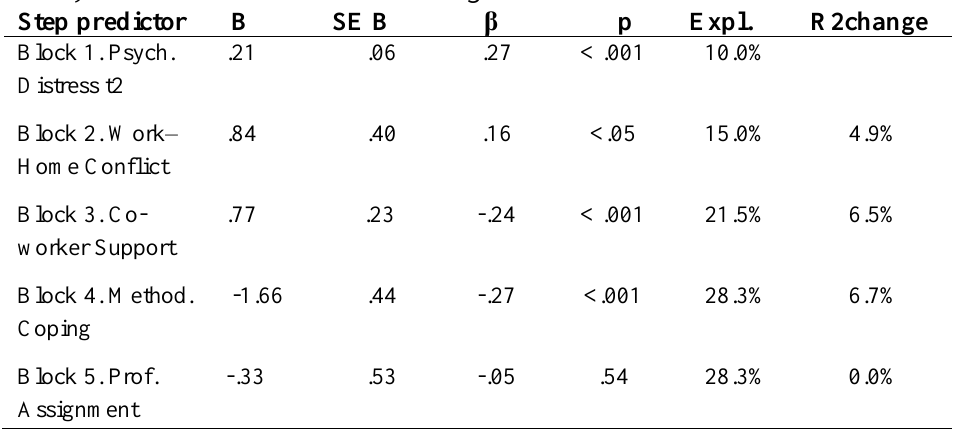
Hierarchical Multiple Regression Analysis. Prediction of Psychological Distress* three years after finishing the Bachelor Educations by Psychological Distress at t2, Work-Home Conflict, Co-Work Support, Experience of methodological coping at work, and Professional Educational